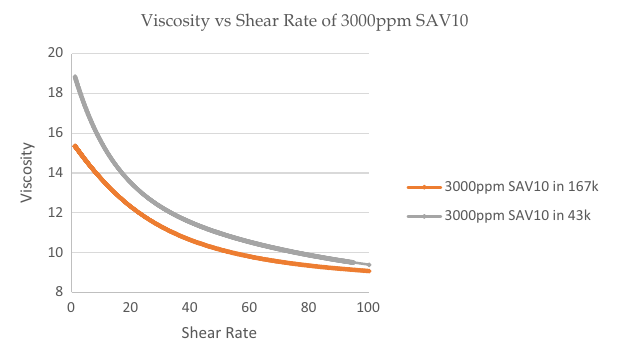
Fig. 15 Effect of salinity on SAV10